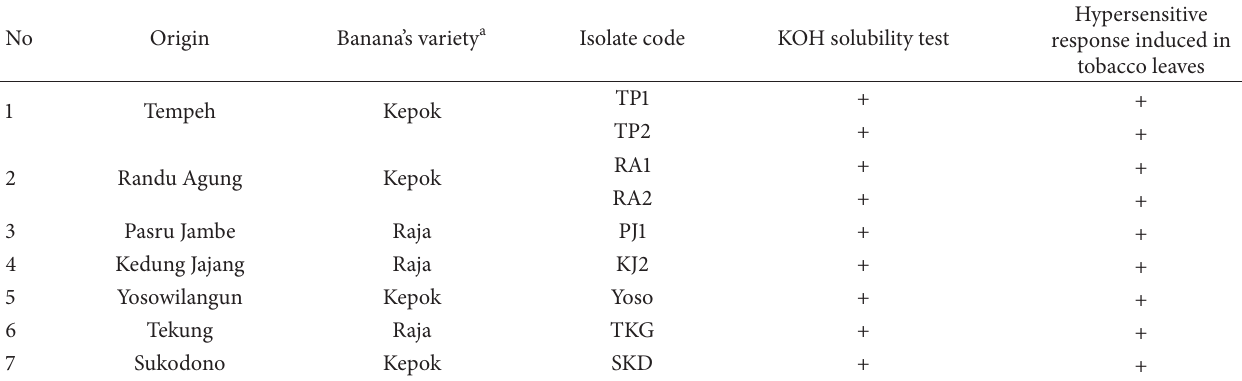
Table 1: Bacterial isolates used in this study.